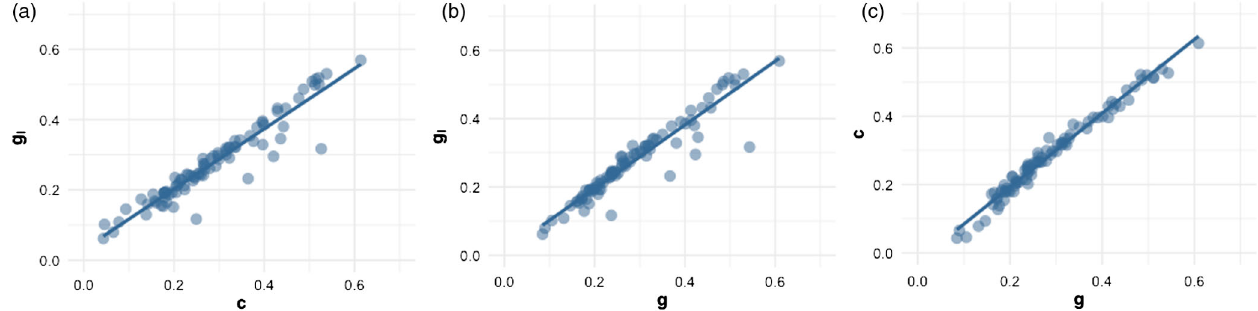
FIG. 1. Scatter plots comparing the course average value for the three forms of normalized